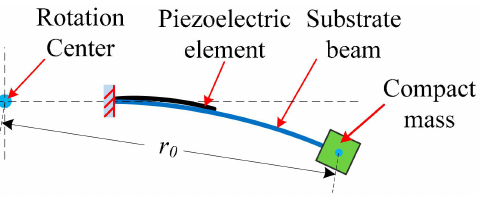
Figure 1. Schematic of a conventional cantilever beam structure with compact mass in a rotational energy